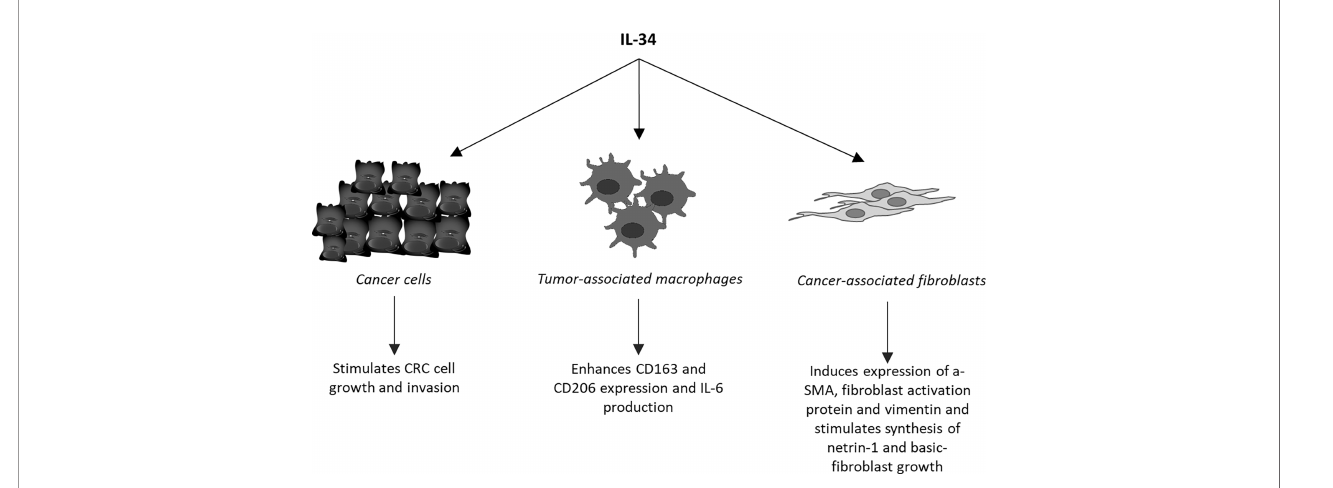
FIGURE 2 | Schematic view of the cell targets and biological effects of interleukin-34 (IL-34) in human colorectal